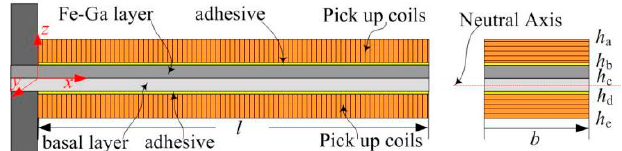
Figure 2. Simplified mechanical schematic diagram of the harvester; the inset shows a diagram of the cross section.